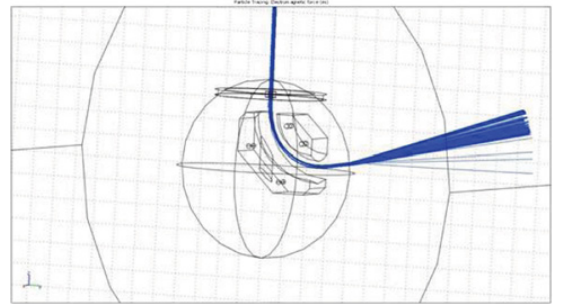
Figure 16. Simulation of 500 eV proton (blue lines) through the electric deflector ( U ± = 208V). The divergence of the beam is 1.4% (velocity).